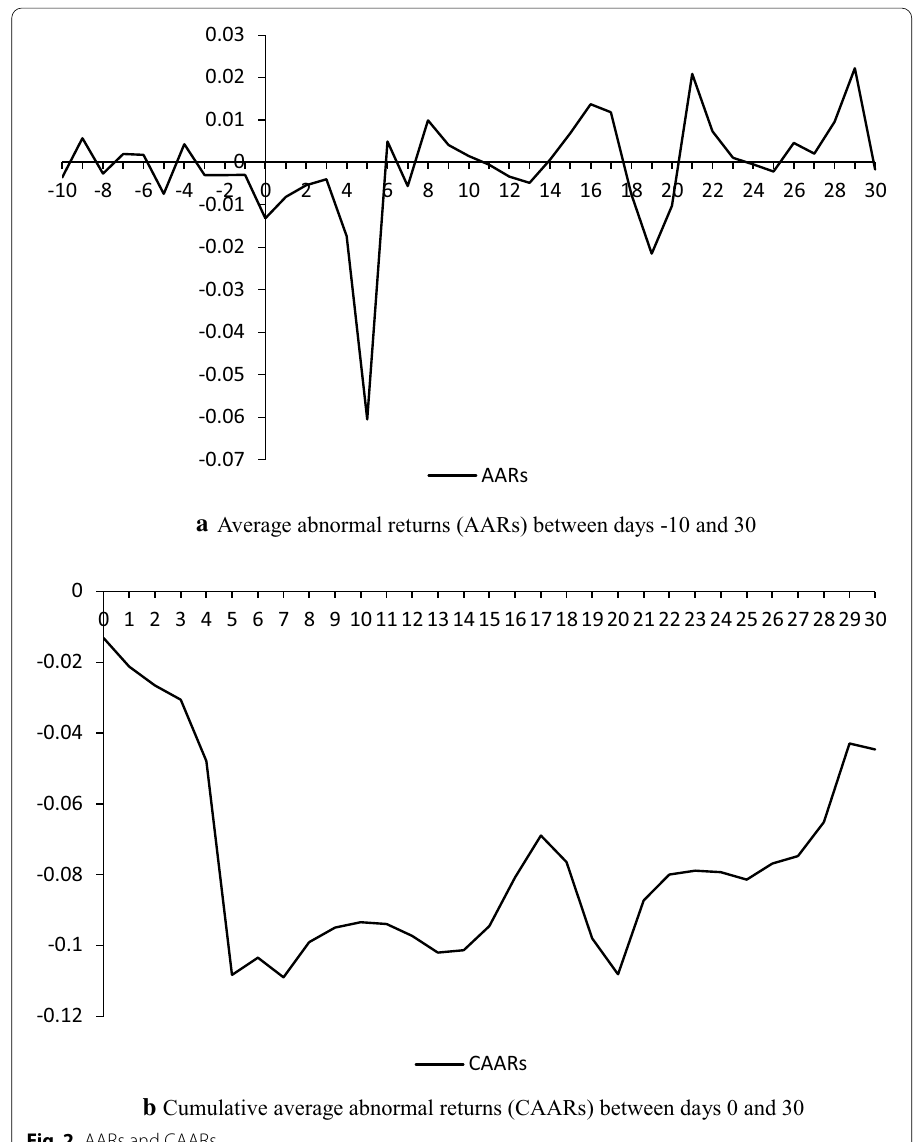
Table 4 columns (1) and (2) represent the results of panel regression. After con- trolling for firm-specific characteristics and the growth rate of COVID-19